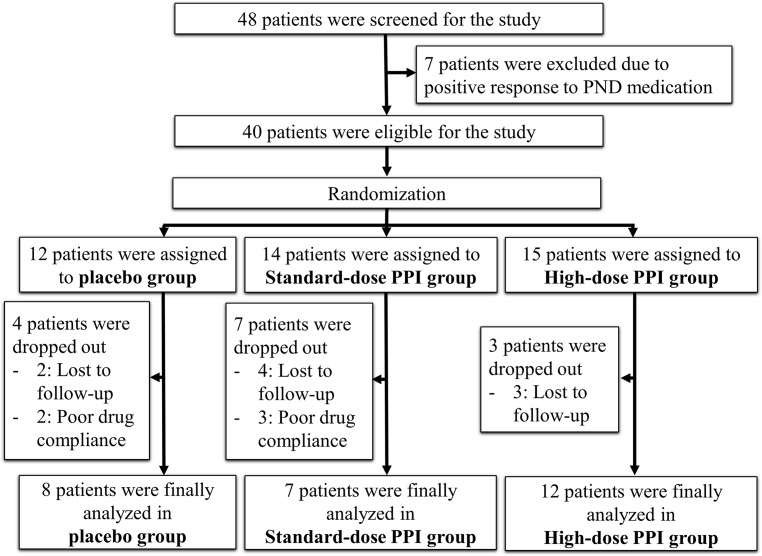
Study flow.PND, postnasal drip; PPI, proton pump inhibitor.